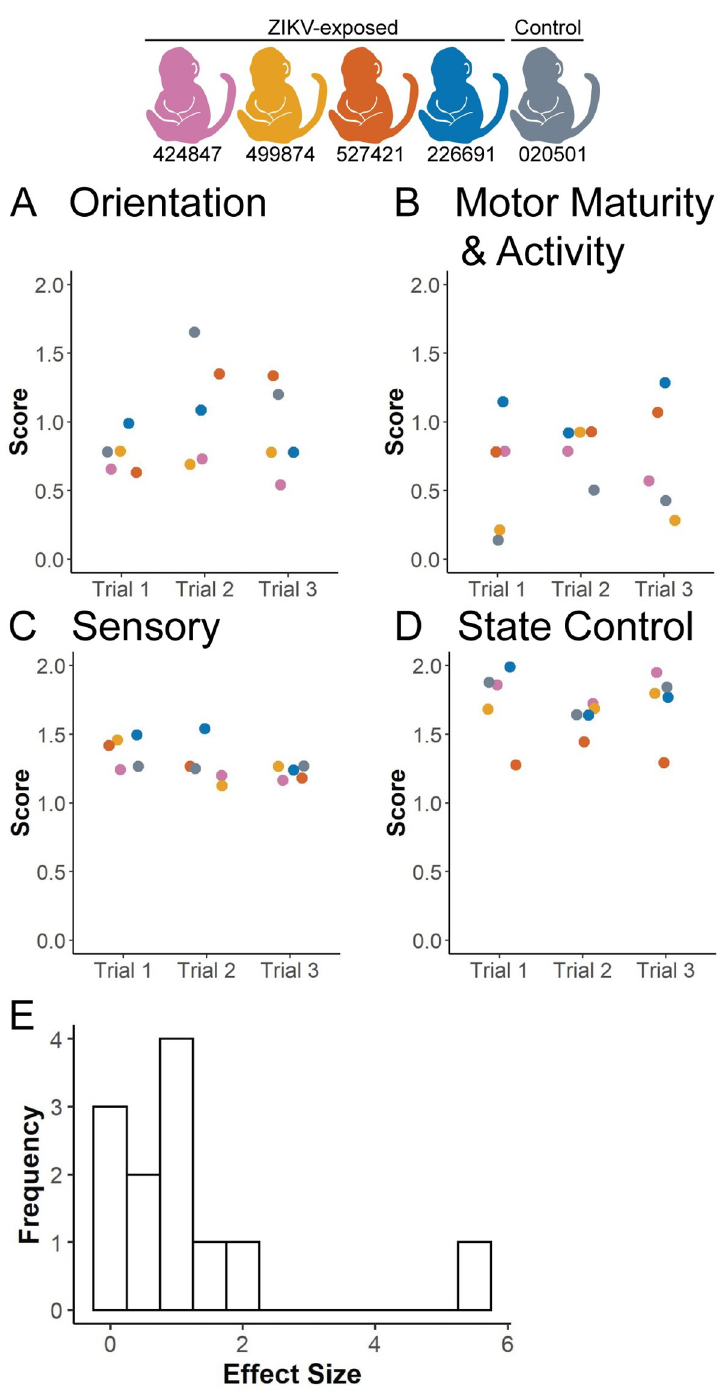
Fig 7. Neurobehavioral assessment. The (A) Orientation construct, (B) Motor Maturity and Activity construct, (C) Sensory construct and (D) State Control construct were assessed on three separate days (Trials 1–3) during the infants’ 8 days of life before necropsy, as described in S2 Table. Test items are scored from 0–2, with 0 representing no response or performance and 2 representing a higher performance of the measured behaviors. (E) A histogram illustrates the distribution of effect sizes for all four constructs at each of the three time